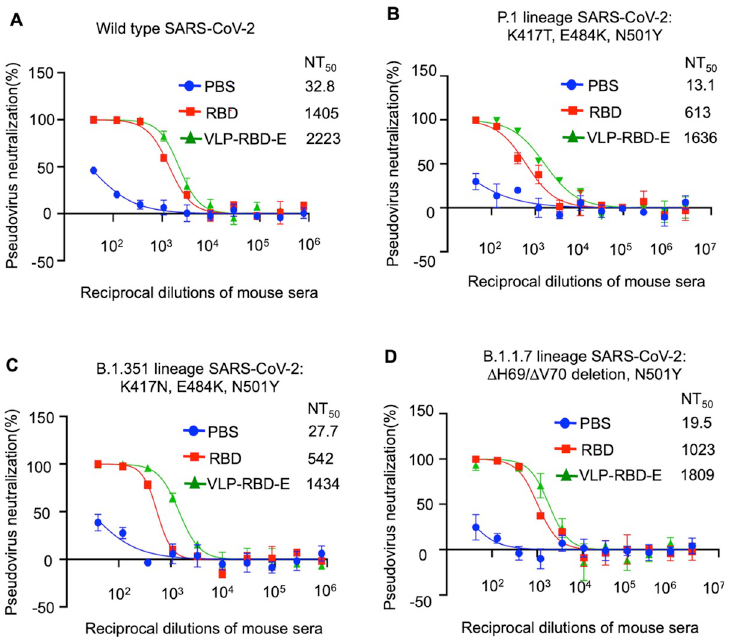
Fig 4. Antibody responses induced by VLP-RBD vaccine potently neutralize the cell entry of pseudotyped SARS-CoV-2 variants. The experiments were performed in the same way as in Fig 3A, except that a different pseudovirus system was used (see Materials and Methods) and also the mouse sera in each immunization group were pooled together. The mutations in the S1 subunit of the SARS-CoV-2 variants (each defined as a lineage) are listed. Except for the Δ H69/ Δ H70 deletions, all of the other mutations are located in the